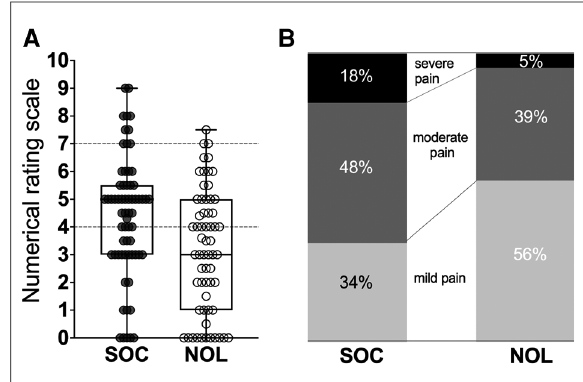
FIGURE 1 Boxplots of the effect of intraoperative nociception level (NOL)- guided fentanyl dosing and standard care (SOC) on postoperative pain scores.